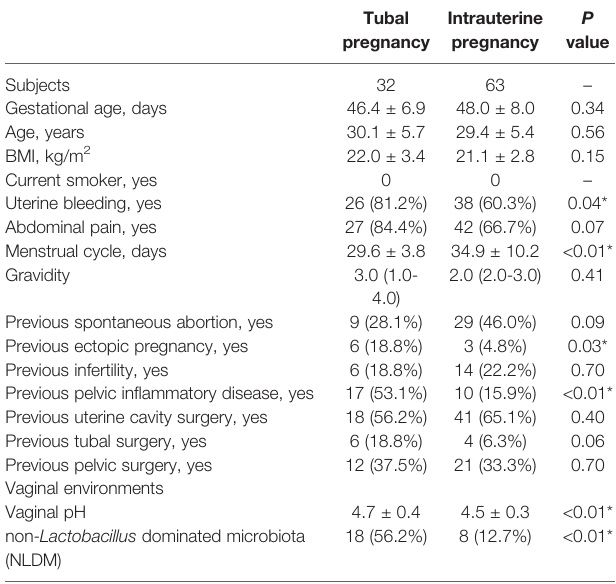
TABLE 1 | Characteristics of subjects with tubal pregnancy compared with those with intrauterine